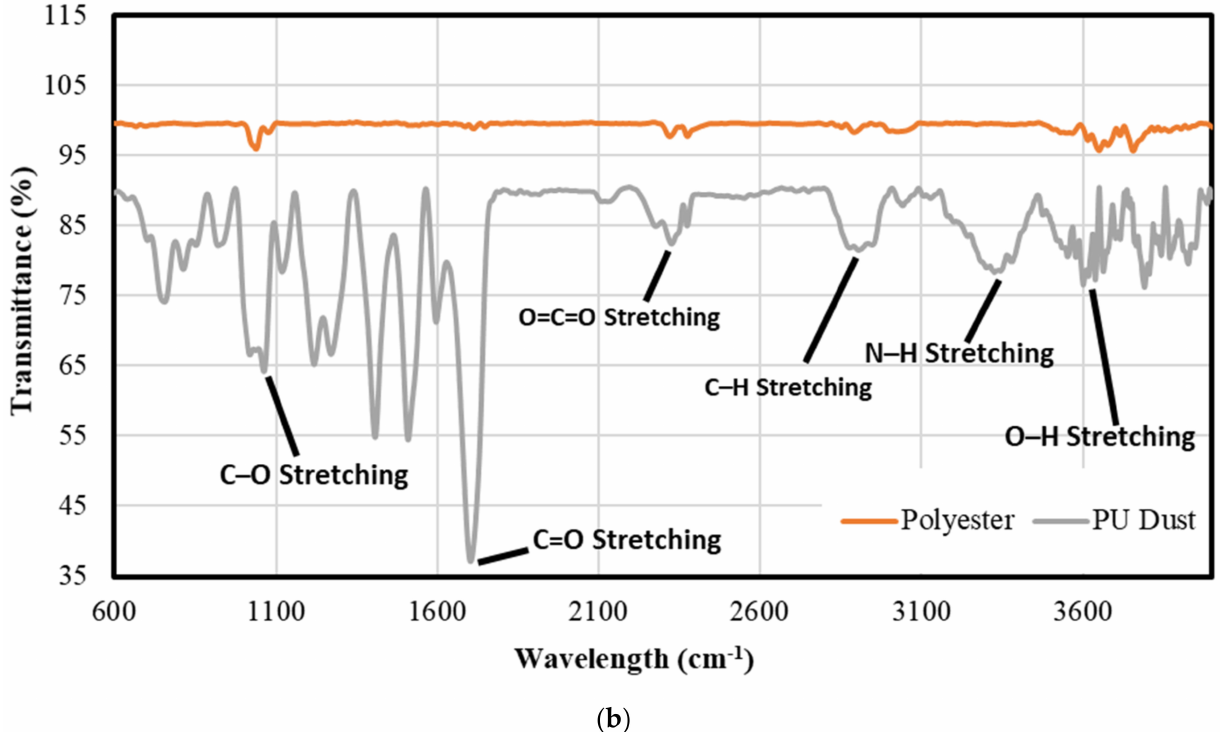
Figure 3. FTIR analysis for ( a ) UPR, 10PUD, 30-PUD and 50-PUD composites; ( b ) pure UPR and